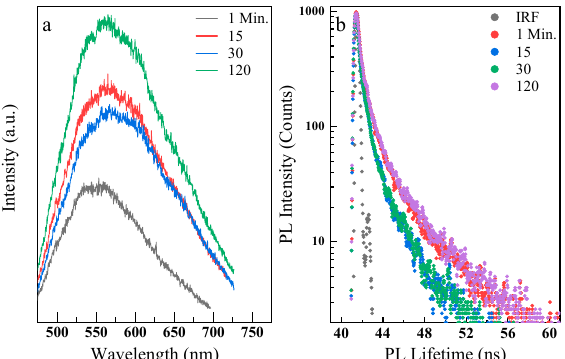
Figure 8. Baking time effect on the nanoparticles deposited at 2 torr and baked at 300 °C. PL spectra increase as the baking time increases ( a ). This is possibly due to defects reduction. The average PL lifetime decreases up to 30 min baking time and then increases at 120 min ( b ).